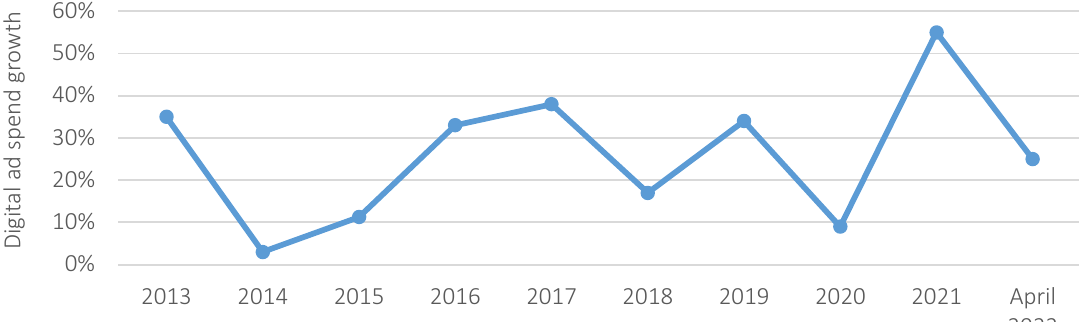
Figure 3. Annual growth rates of digital ads` spending in Ukraine from 2013 to April 2022